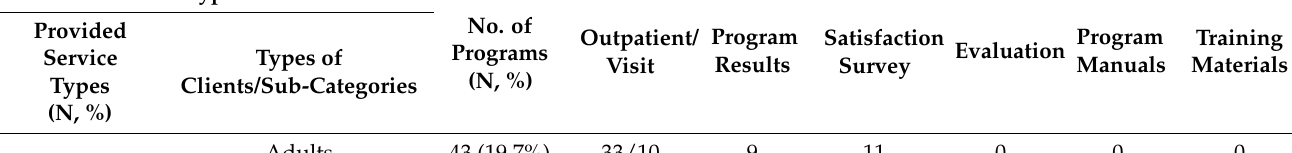
Table 2. Types of TKM services provided by